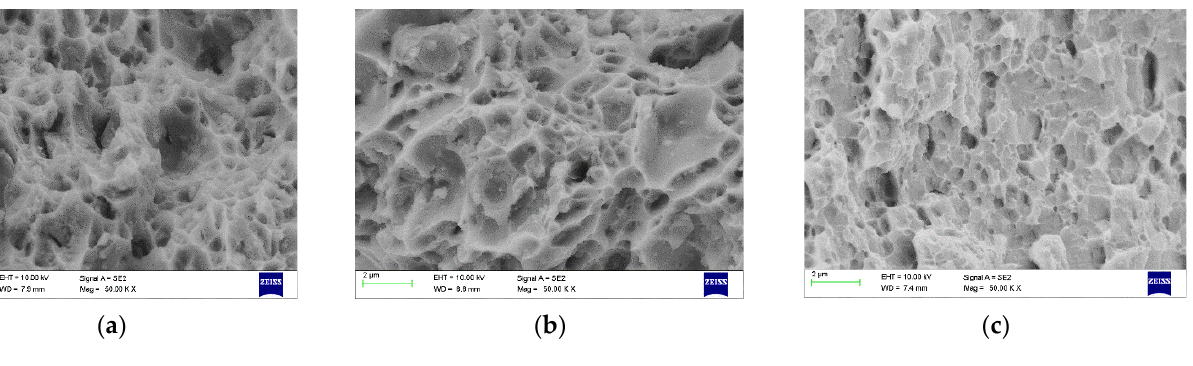
Figure 24. Fractography SEM image of 7075 ( a ) 1% Gr ( b ) 2%Gr ( c ) 3%Gr.